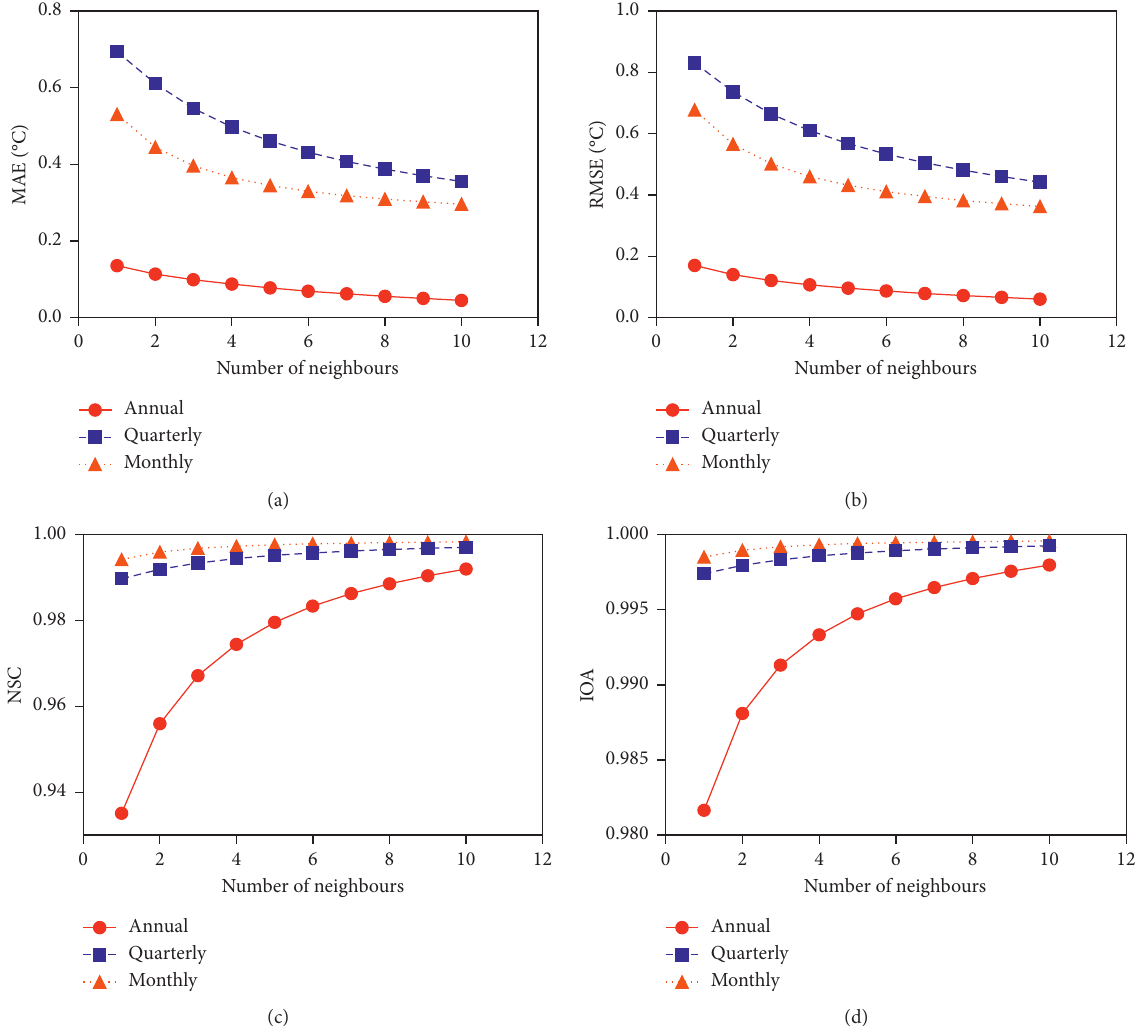
Figure 2: Comparison of kernel regression evaluation indicators of multiple neighbouring stations in the Jiangsu area: (a) MAE; (b) RMSE; (c) NSC; (d)